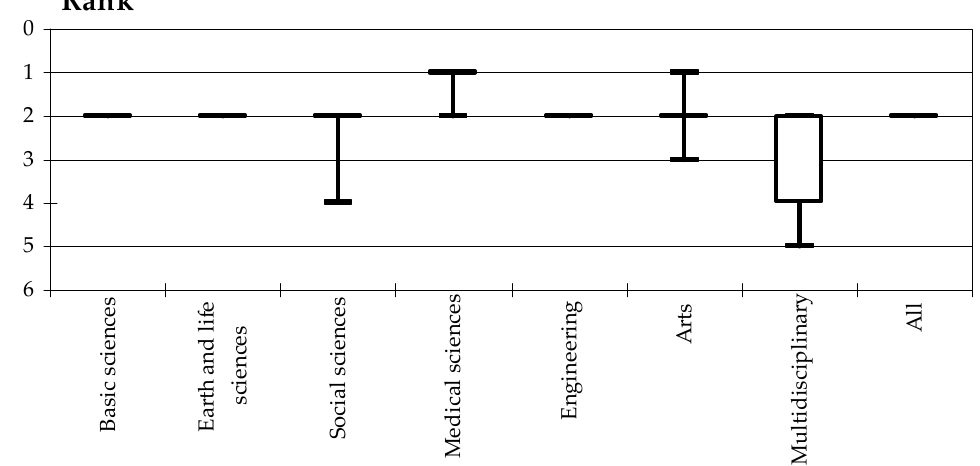
Figure 5. The number of documents published in different aggregated research areas in Poland during 2010–2018, measured based on the adjusted number of citations per document. The figure displays boxplots of the ranks of fields computed for each year separately. Results indicate that the ranks cluster in the first quarter of the ranking.